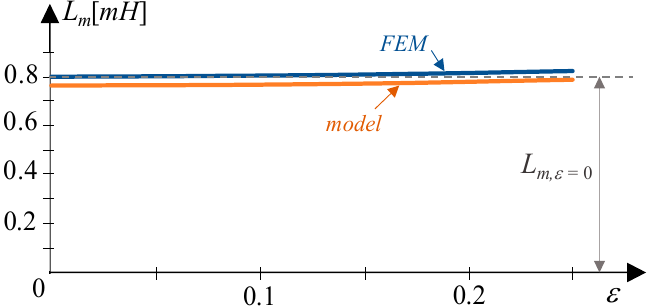
Figure 14. Air gap mutual inductance as a function of ε . Results of the model (brown line) and of FEM analysis (blue line).